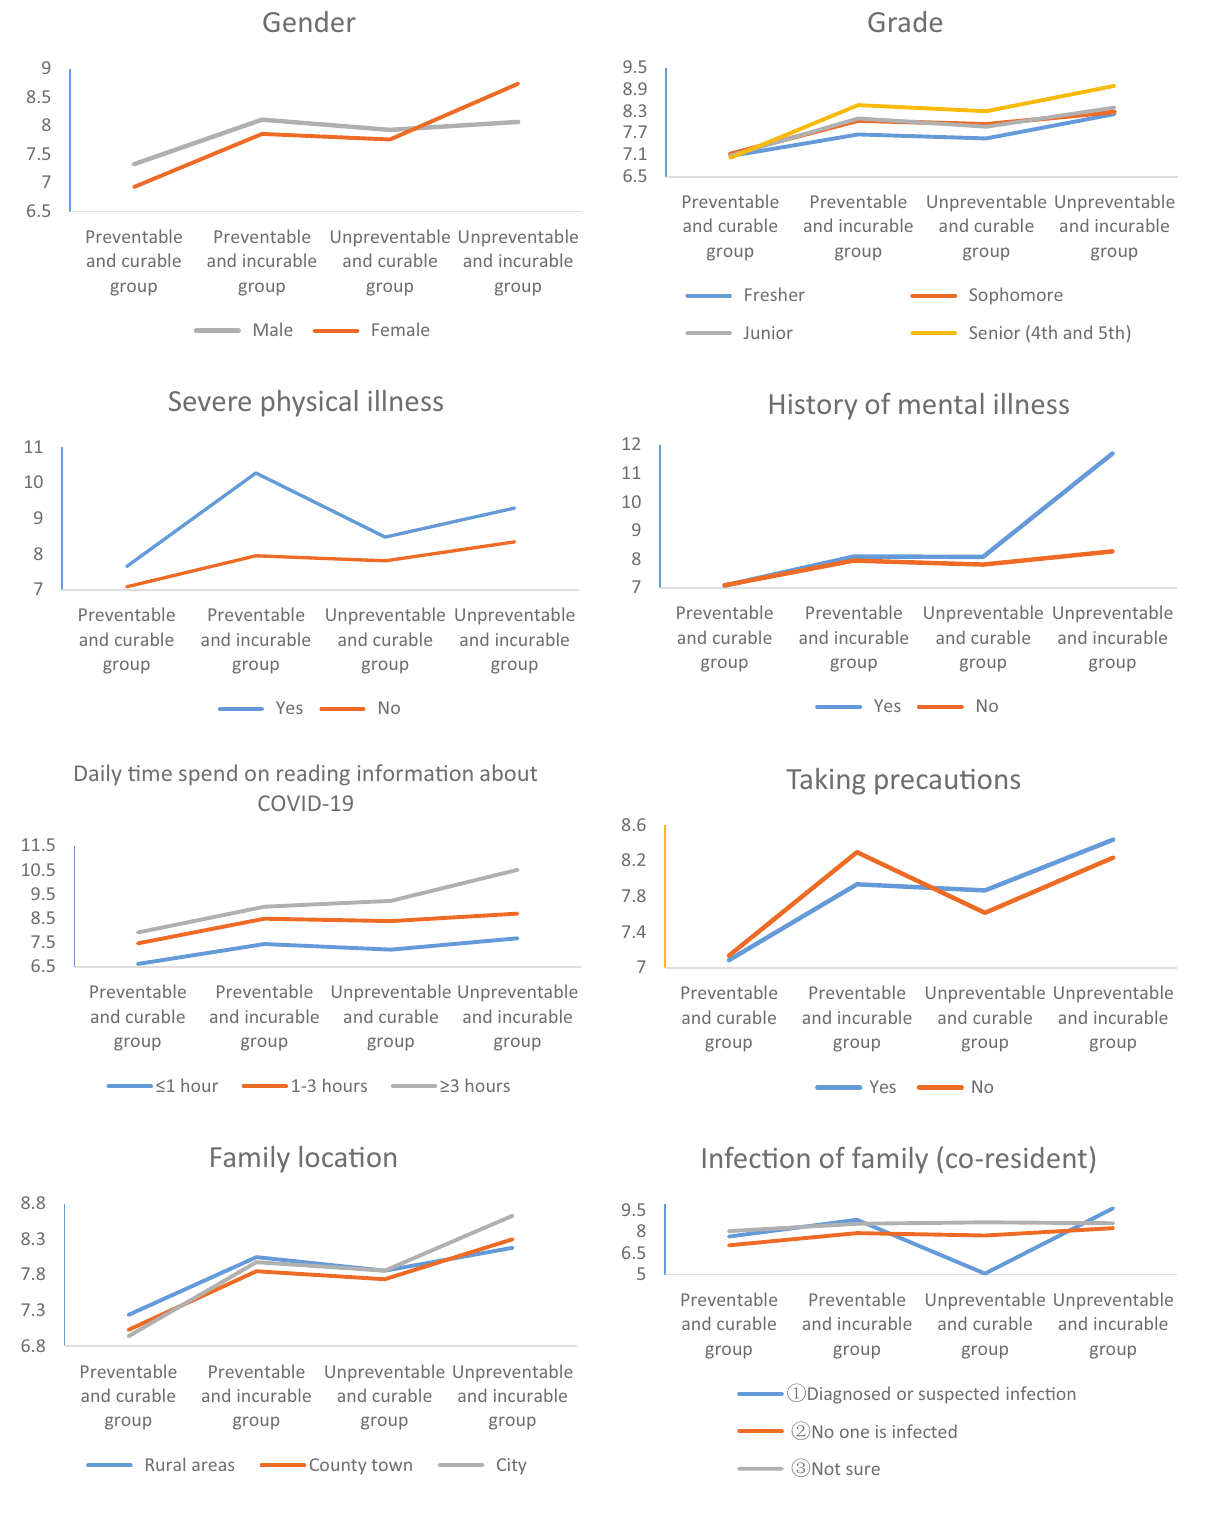
FIGURE 1 | Associations between psychological stress symptoms, demographic data, and